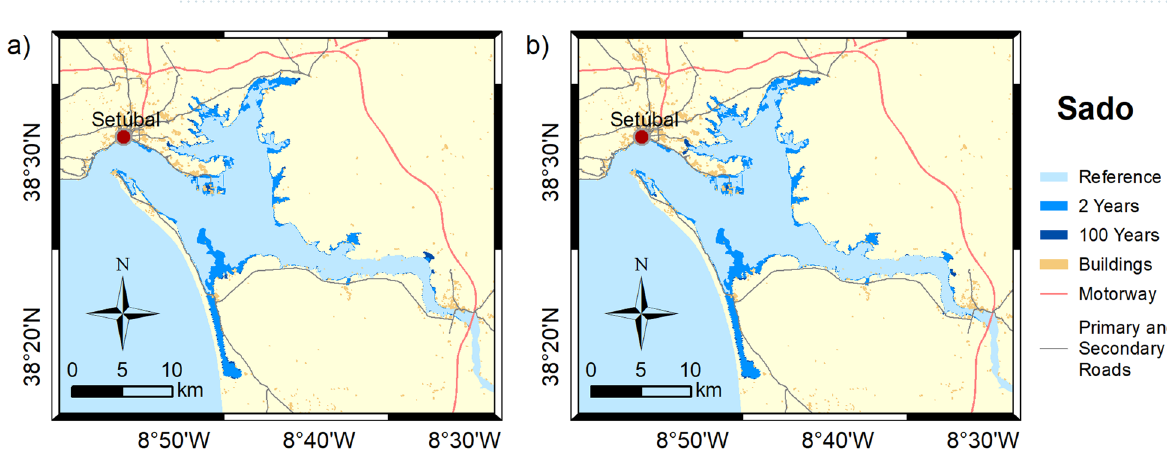
Figure 6. Inundation extents induced by extreme sea levels with return periods of 2 and 100 years on the Sado estuary in: ( a ) 2046–2065; and ( b ) 2081–2100. These maps were created with Esri ArcGIS 10.8 software (https:// www. esri. com/ en- us/